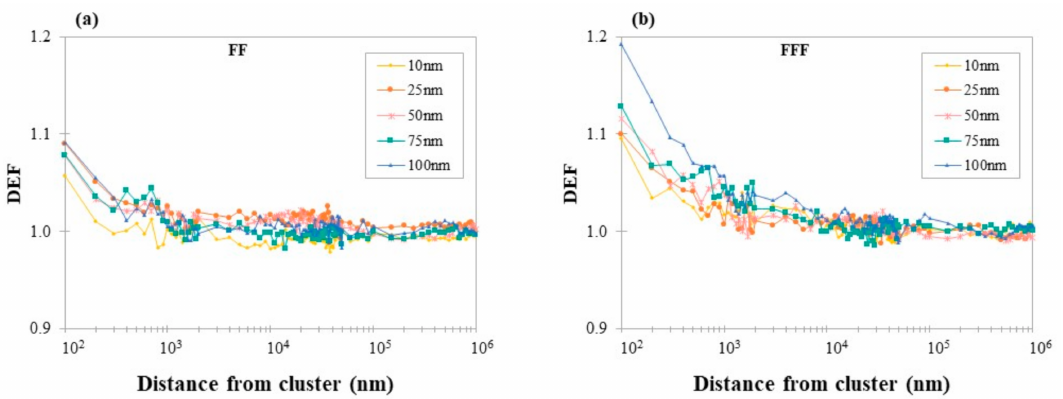
Figure 3. ( a ) Calculated DEF as a function of distance from different sized AuNPs clusters in case of 6 MV photon spectrum in presence of FF; ( b ) Calculated DEF as a function of distance from different sized AuNPs clusters in case of 6 MV photon spectrum in absence of FF. The X-axis is on a logarithmic scale. The photon field used to irradiate AuNPs clusters was 5 × 5 cm 2 . AuNPs clusters were positioned at a depth of 2 cm inside the mathematical water phantom. Uncertainty is below 1.6% per voxel and is not depicted. Points are connected with lines for illustration purposes.